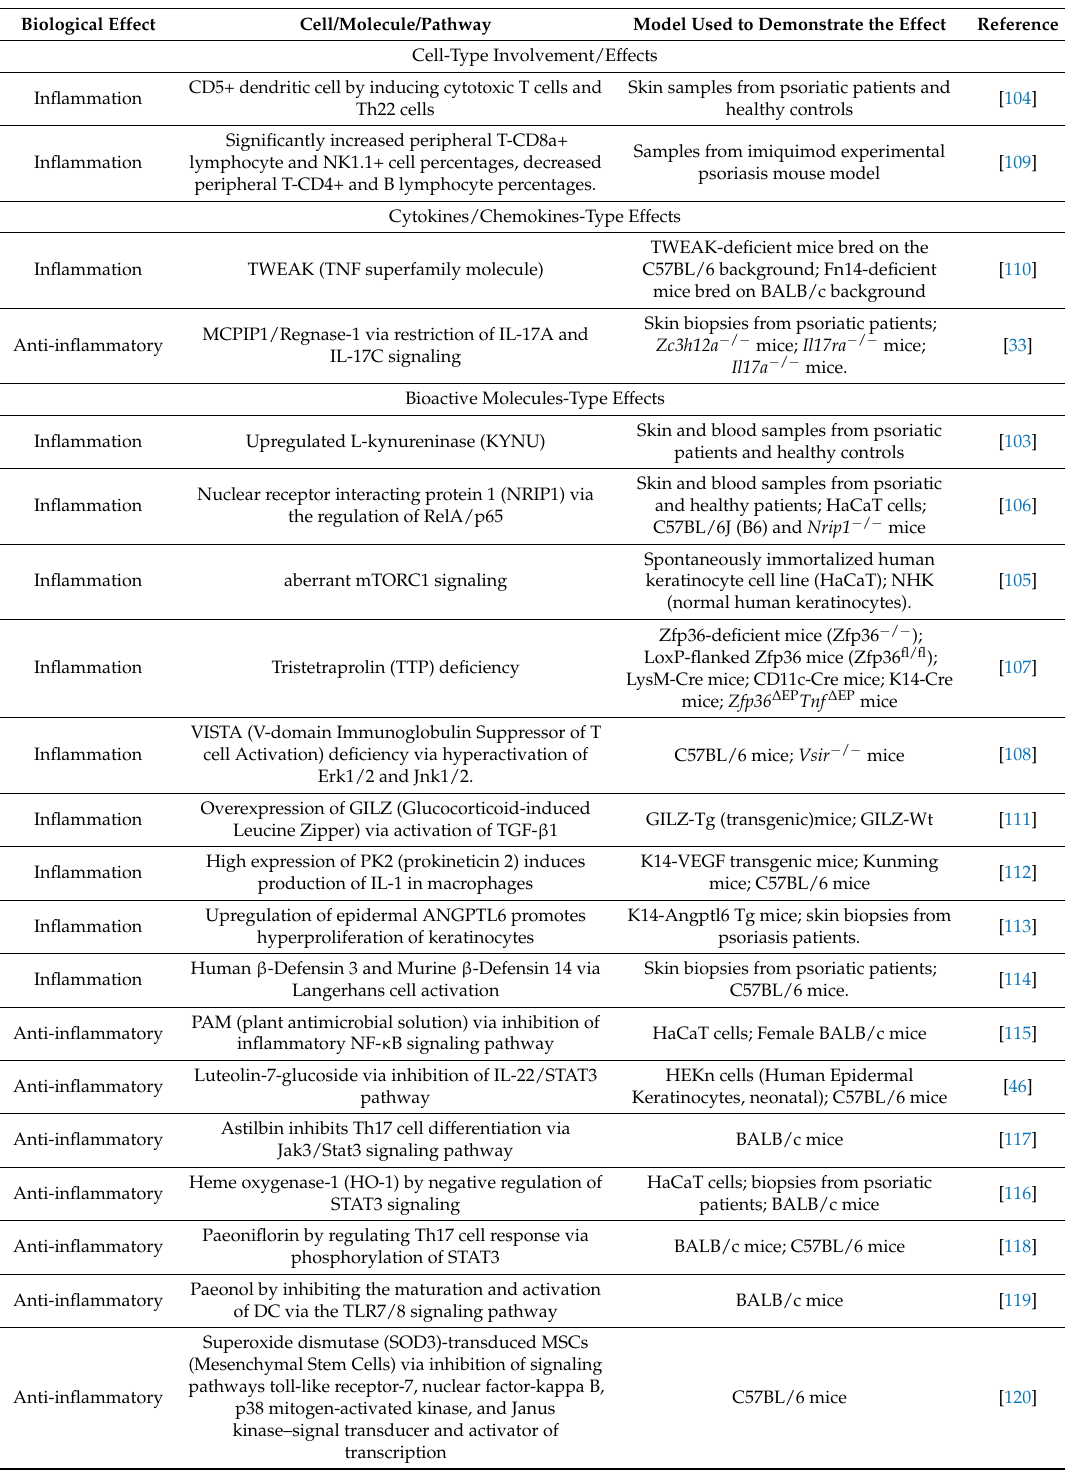
Table 1. Overview of the cell/molecule that induces a particular effect and the subsequent model used to demonstrate the